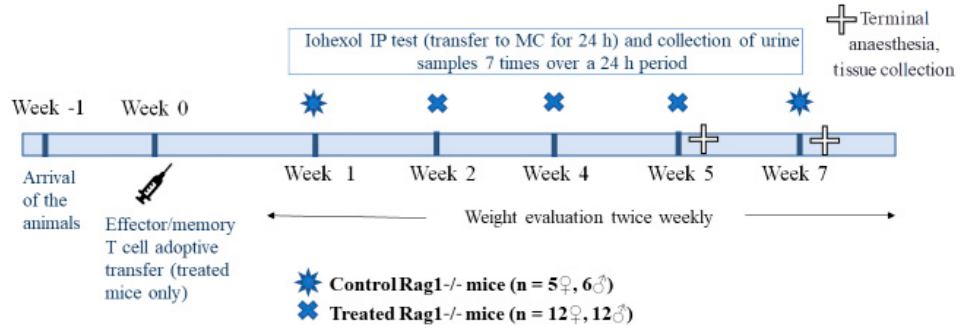
Figure 1. Study design. IP, intestinal permeability; MC, metabolic cage.